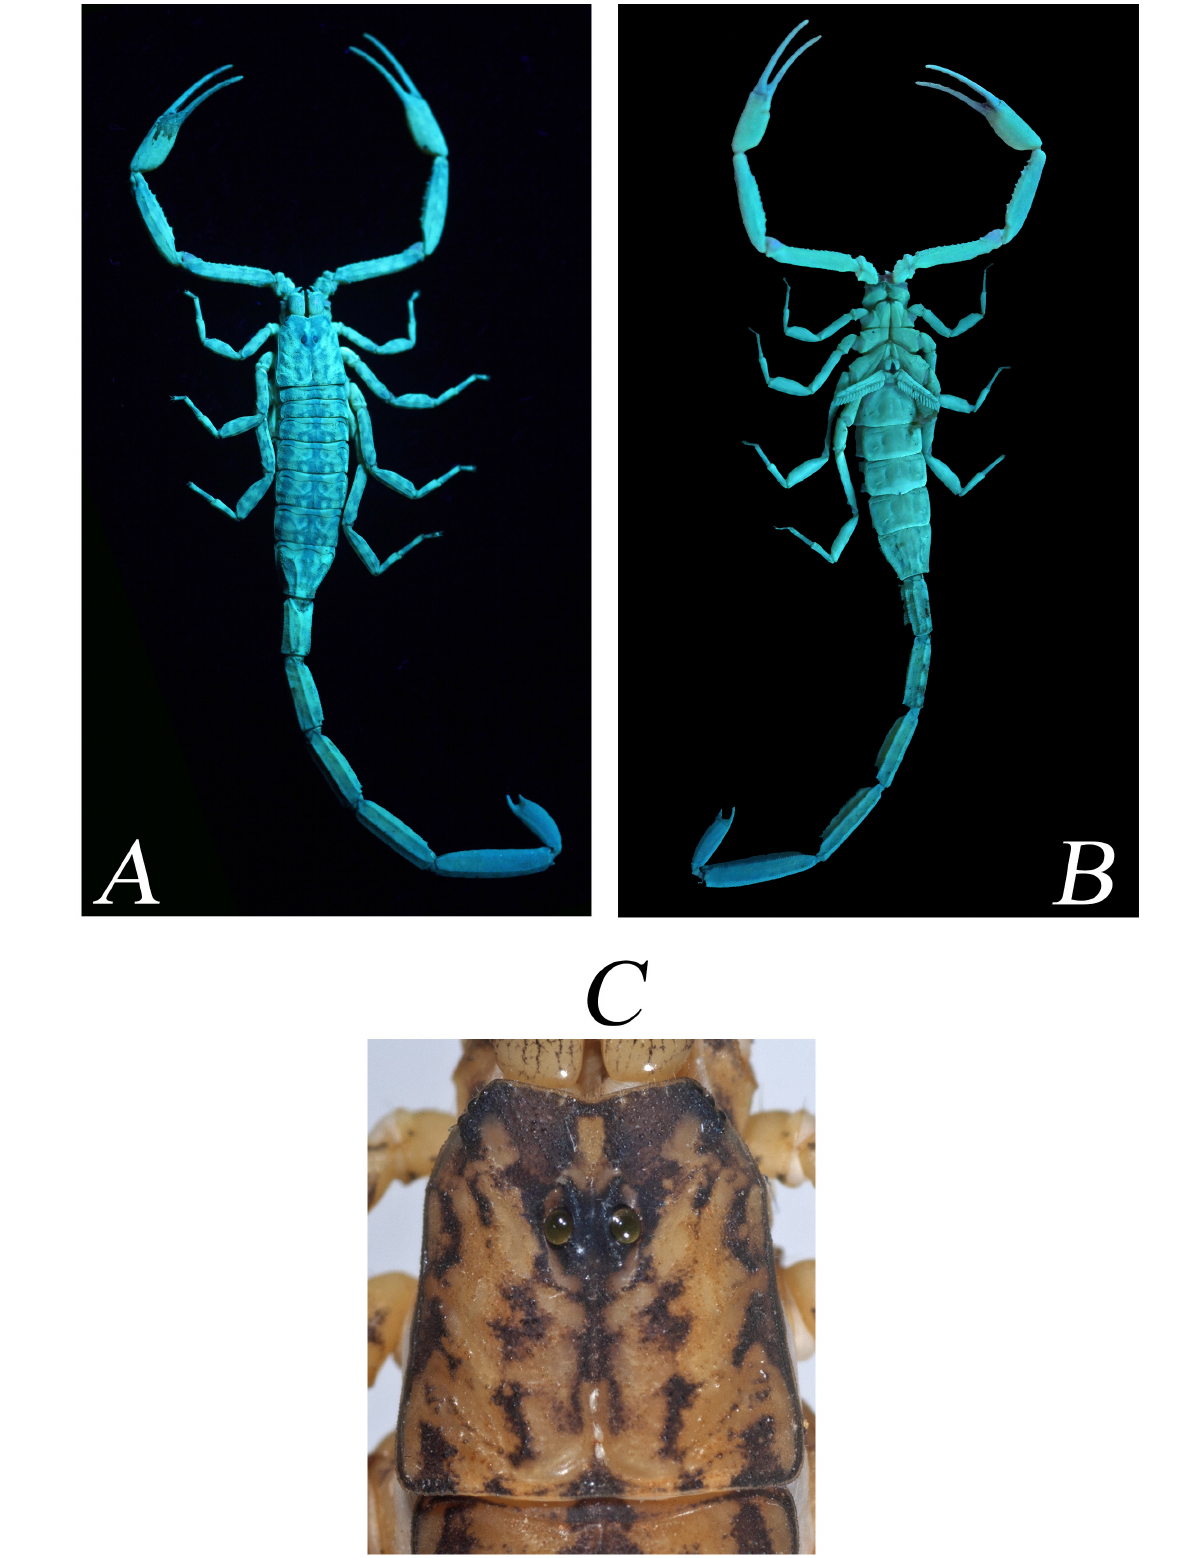
Fig. 14. Isometrus wayanadensis sp. nov., holotype, adult ♂ (BNHS SC 190). A . Dorsal view, UV light. B . Ventral view, UV light. C . Carapace, white